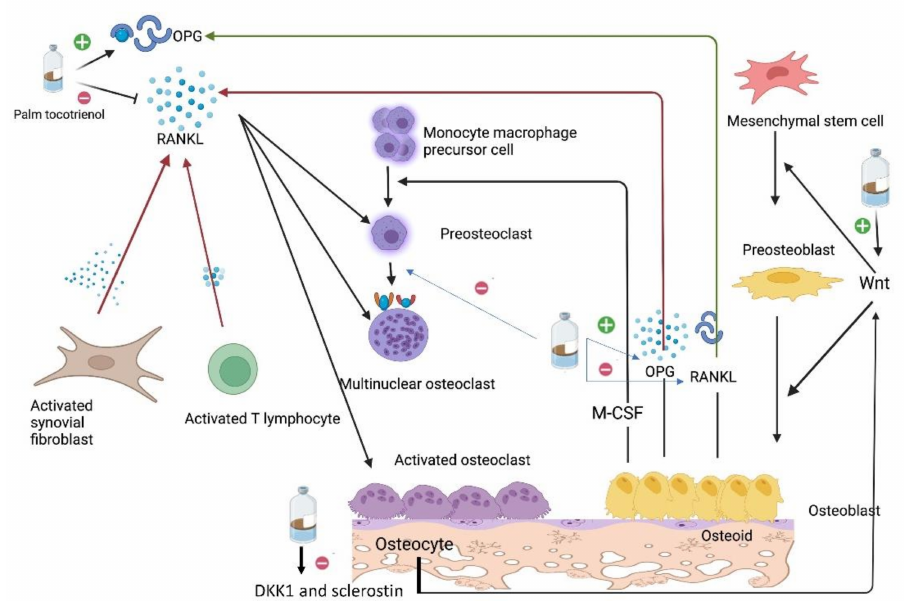
Figure 2. The postulated mechanism of tocotrienol in protecting against glucocorticoid-induced osteoporosis. Tocotrienol can increase OPG secretion by osteoblasts and reduce RANKL secretion by osteoblasts, fibroblasts and immune cells, thus reducing osteoclasts formation. Tocotrienol may also suppress osteoclast formation directly. In addition, tocotrienol can reduce DKK1 and sclerostin levels; thus, the Wnt signalling pathway and osteogenesis are not